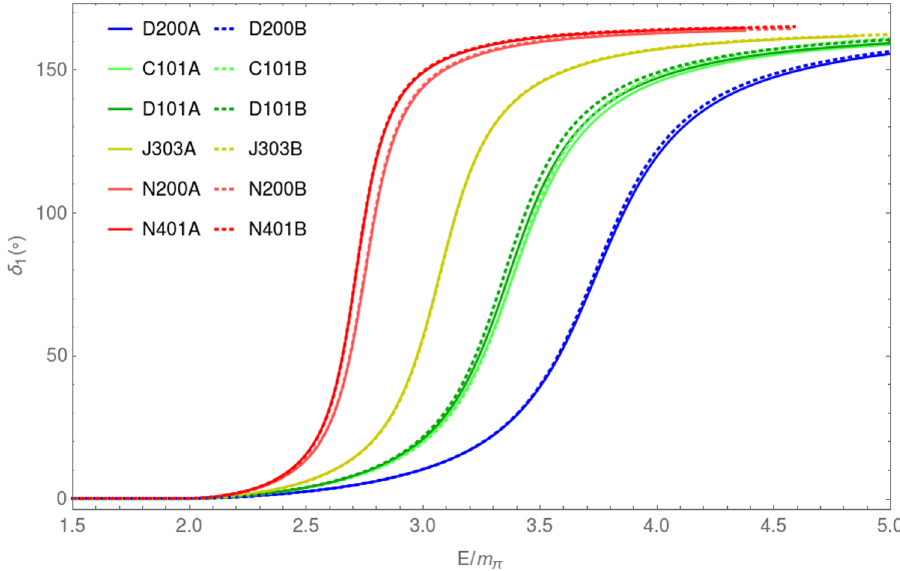
Figure 11 . Comparison between the individual (cid:12)t solutions using A and B scale settings .